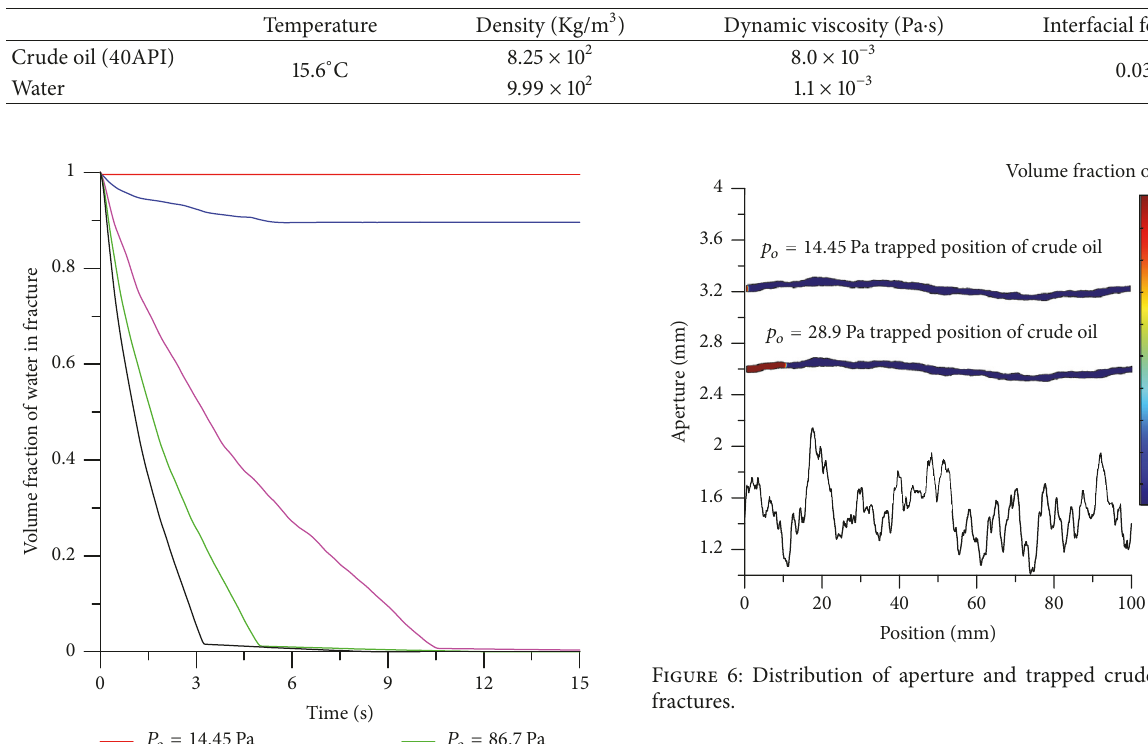
Table 2: Parameter values of the physical properties of crude oil and water.